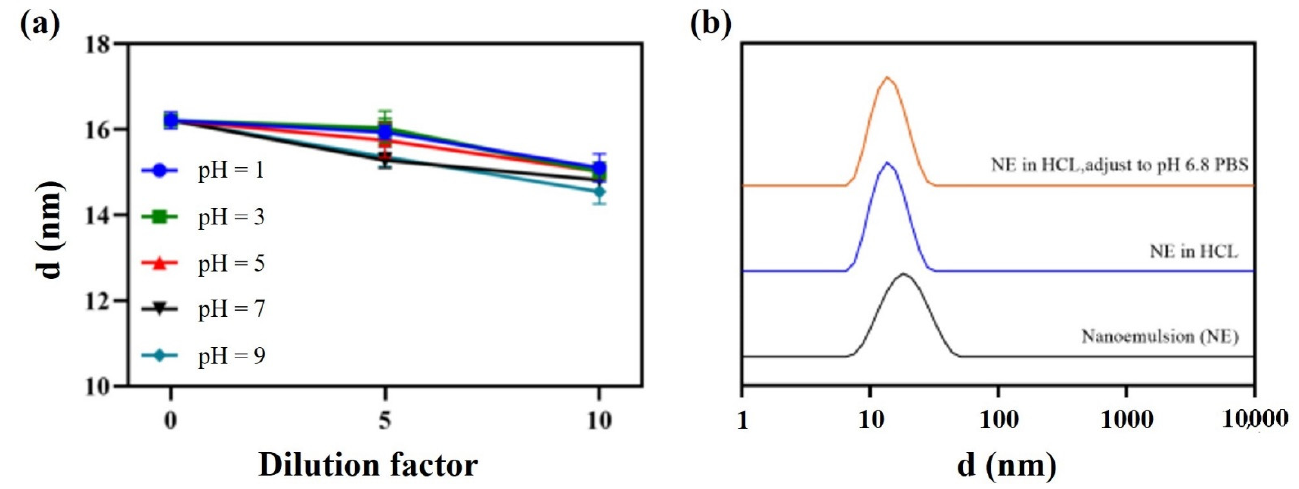
Table 1. Freeze–thaw experiment results of the DAS nanoemulsion.